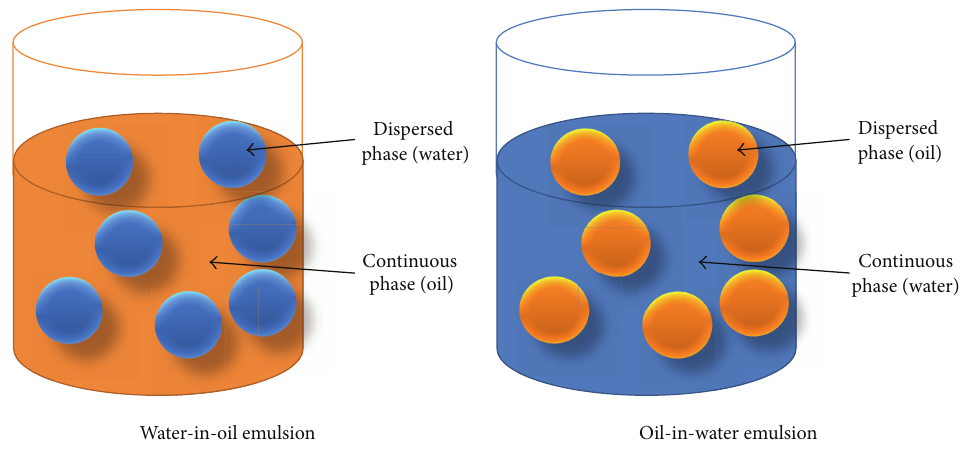
Figure 2: Concept of two-phase water-in-oil and oil-in- water